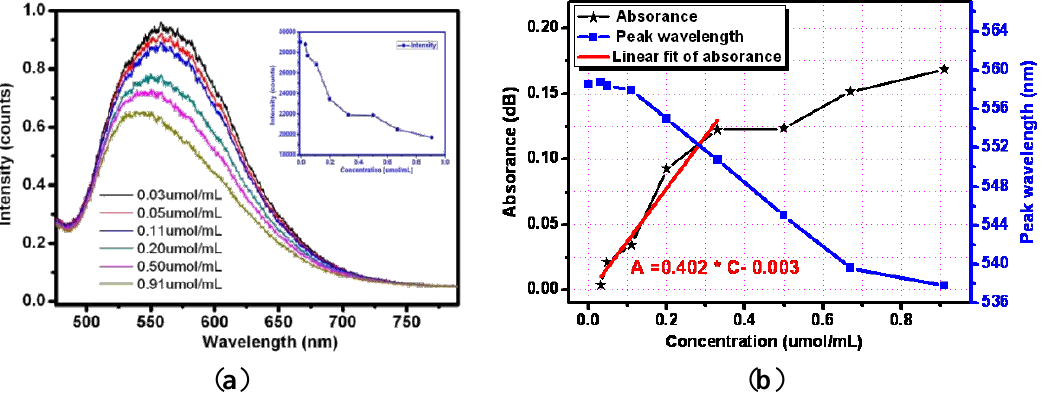
Figure 9. ( a ) Spectra of six different concentrations of methylene blue; ( b ) Test curve of absorbance versus corresponding concentration and plot of absorbance versus concentration of the silver nanoparticle-modified optical fiber